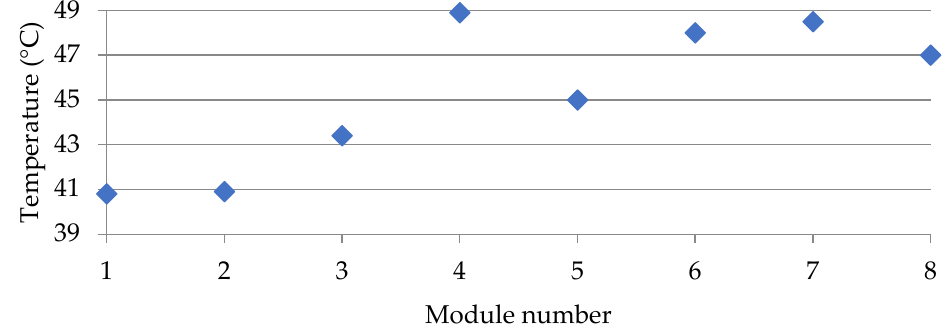
Figure 26. Minimum temperature of modules during measurements.